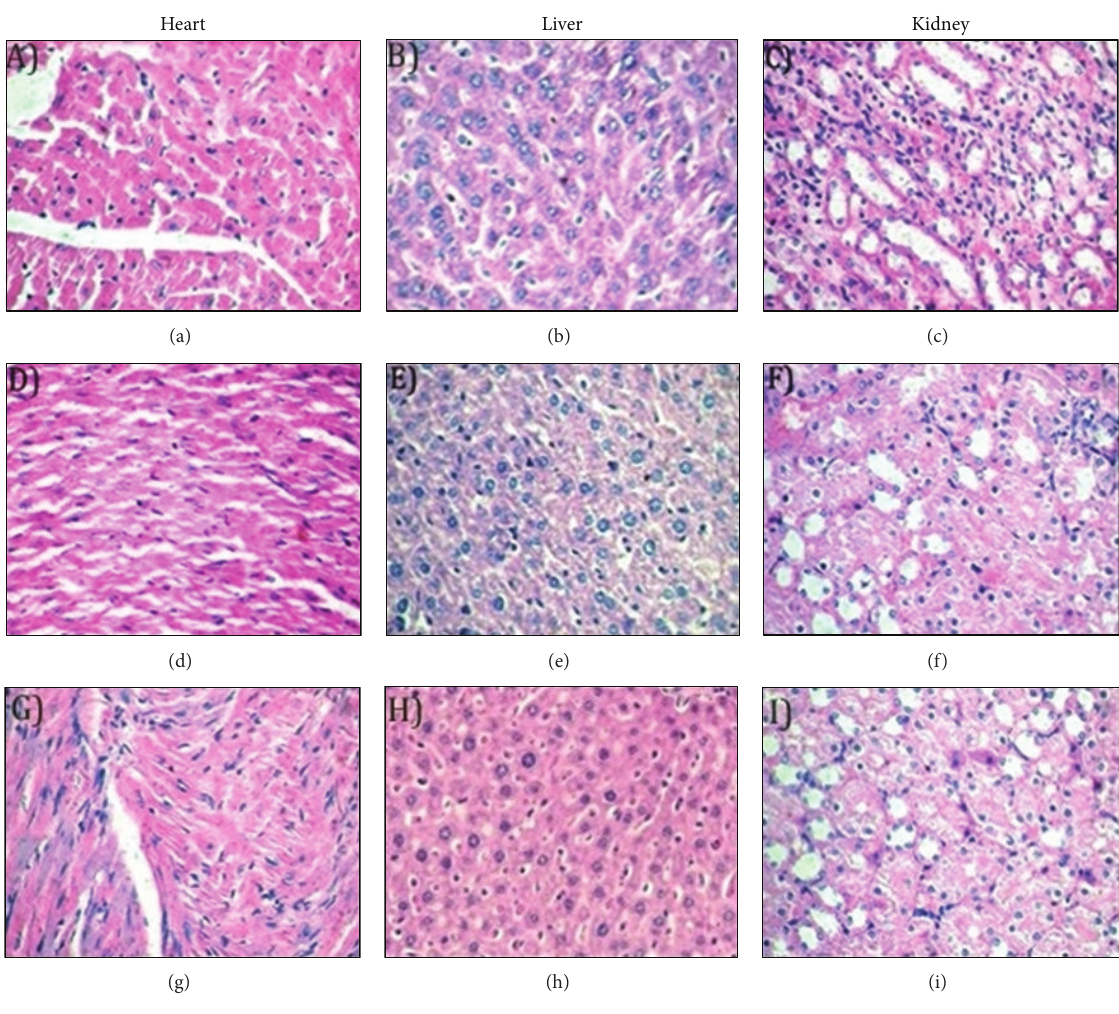
Figure 5: Hematoxylin and eosin (H&E) stained photo micrographs of mice heart, liver, and kidney tissues (20 × magnification). (a), (b), and (c) indicate control, (d), (e), and (f); (g), (h), and (i) show no abnormality in mouse group treated with AE and ME (2000 mg/kg, p.o.),